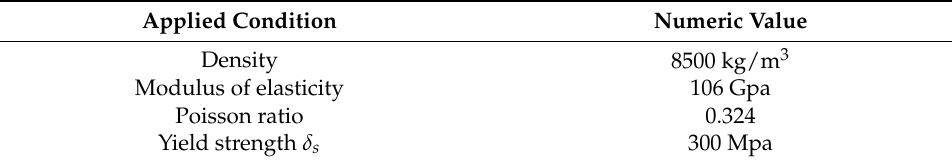
Table 1. Applied flywheel optimisation